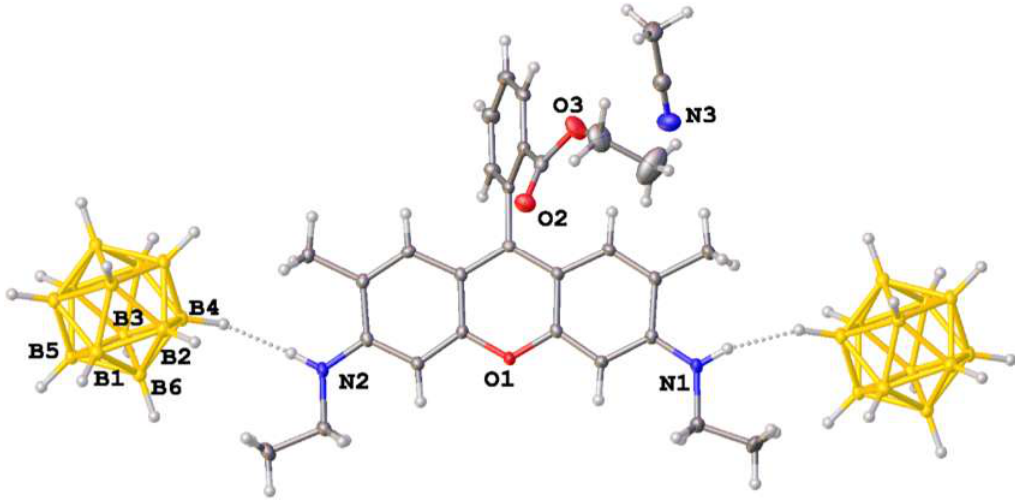
Figure 5. Fragment of the structure of 5 · 2CH 3 CN in representation of atoms with thermal ellipsoids (p = 50%). Only symmetrically independent atoms are labelled. H-bonds are depicted with dotted lines.